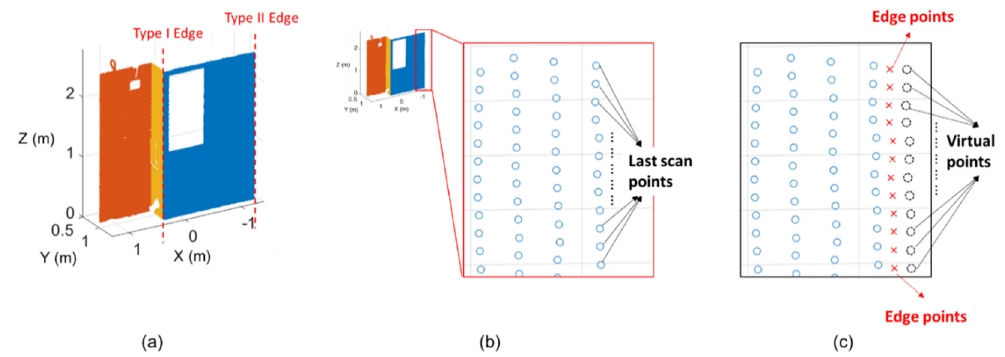
Figure 15. Extraction of as-built surfaces and edges: ( a ) extraction of surfaces, ( b ) extraction of last scan points in each row/column for an edge, and ( c ) estimation of an edge as a set of edge points.